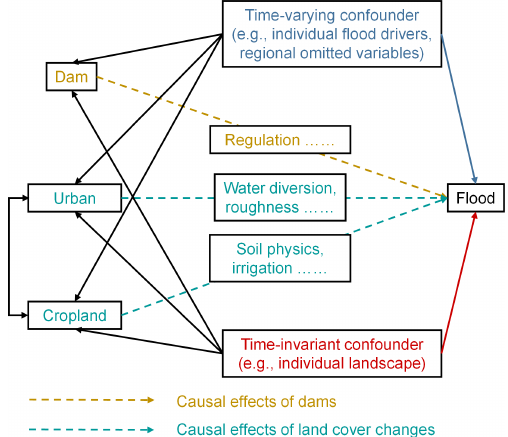
Figure 1. Causal map illustrating the relationships between human factors and